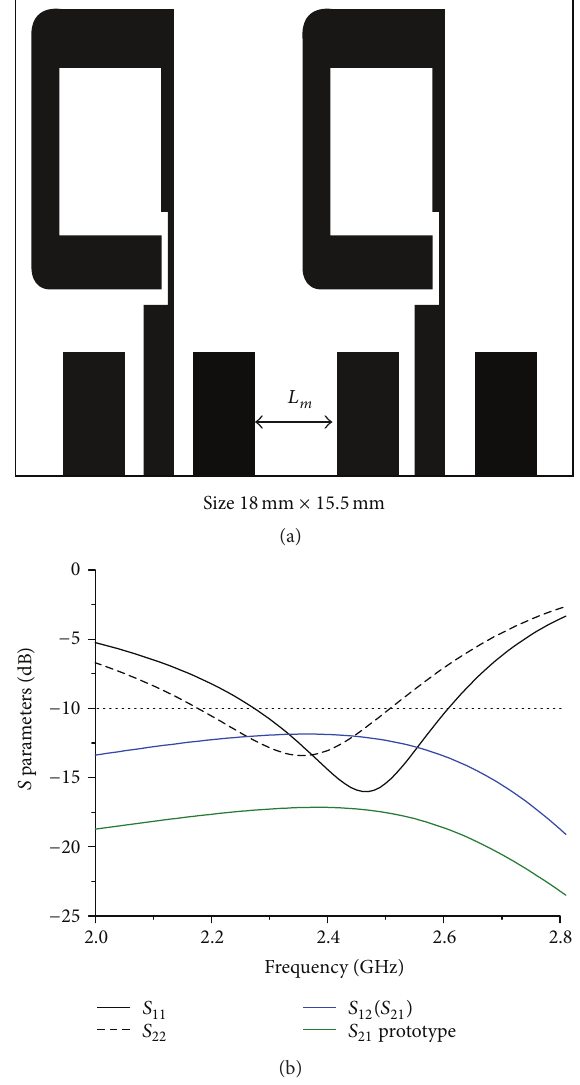
Figure 5: (a) MIMO antenna system Type I, (b) 𝑆 parameters of Type